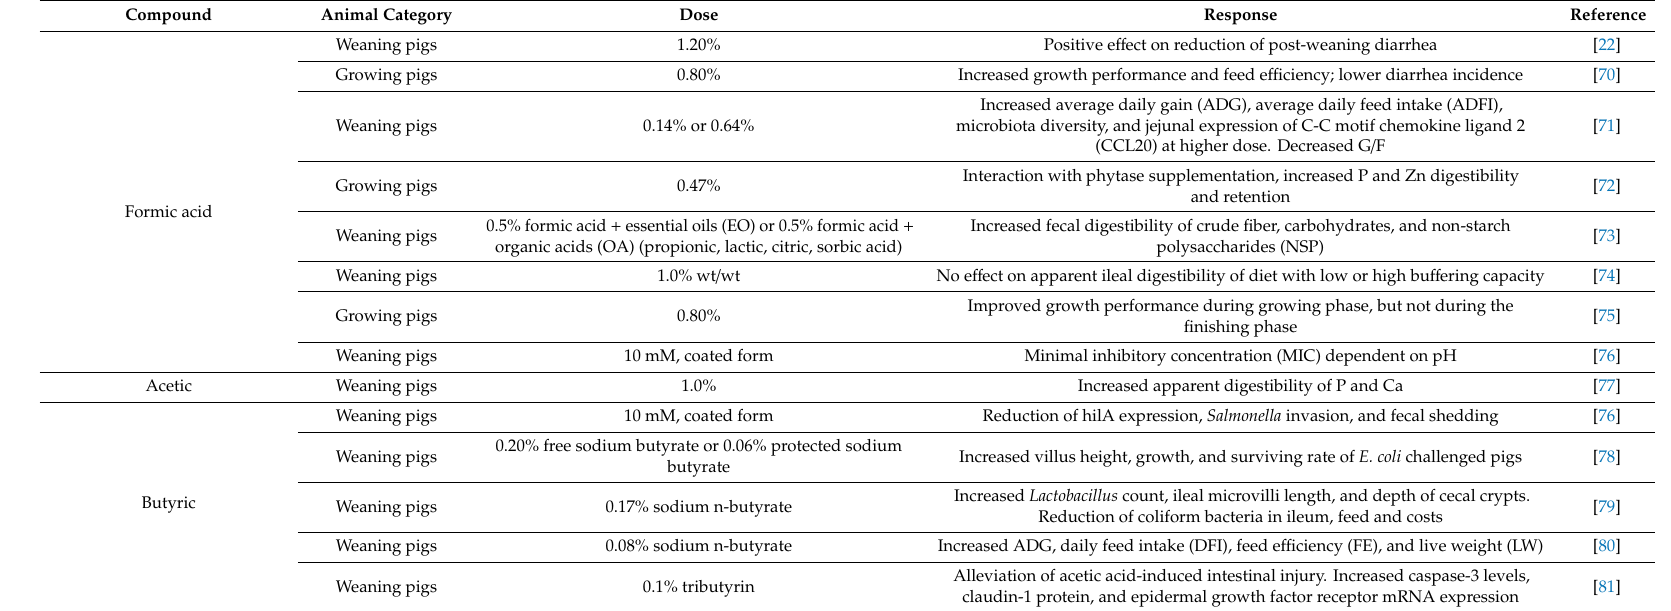
Table 3. Summary of studies about the most common fatty acids used in pig